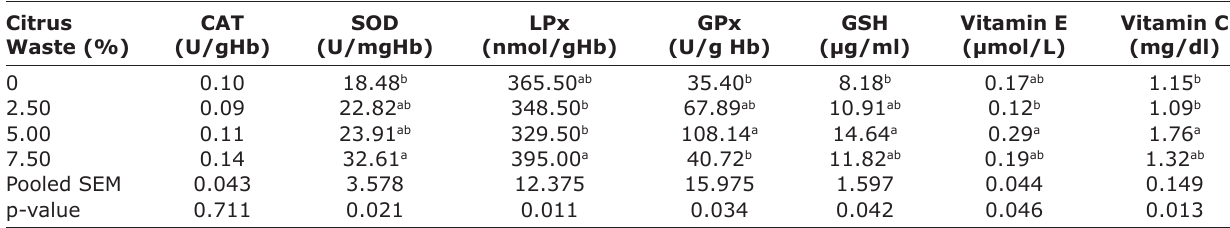
Table-4: Effect of feeding different levels of citrus waste on the antioxidant status of blood in broiler. Citrus Waste (%)